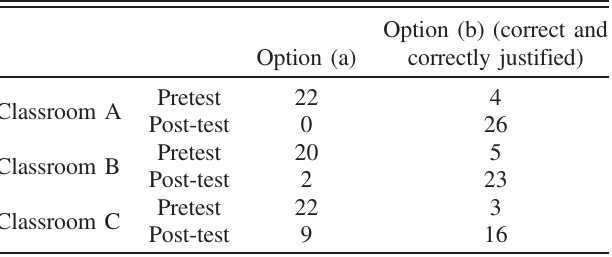
TABLE IV. Students ’ answers to question Q9 for both pretests and post-tests.